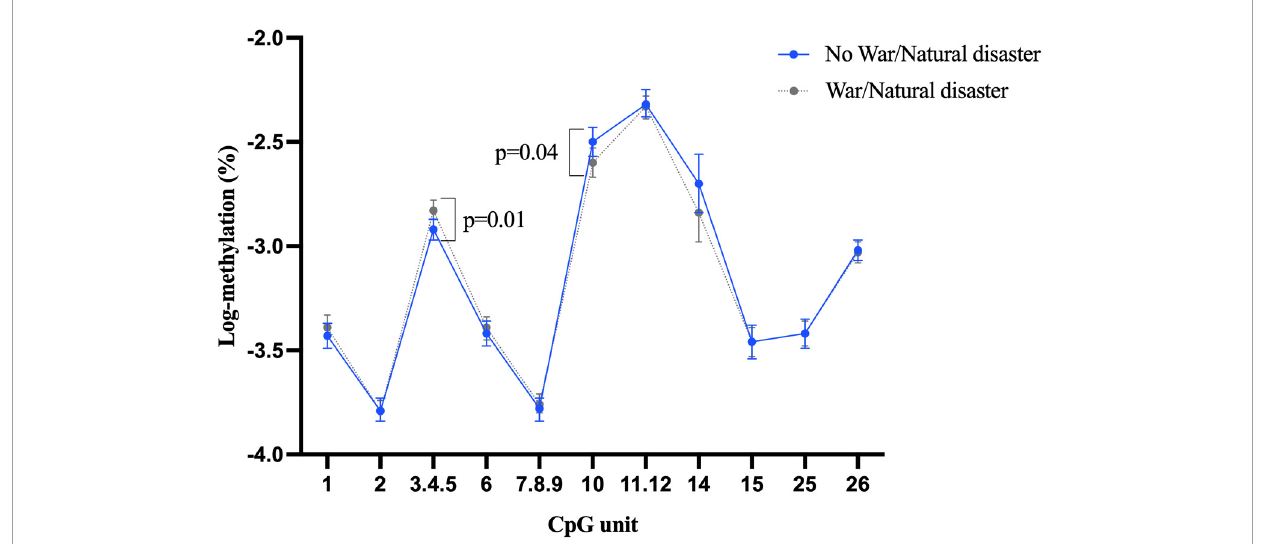
FIGURE1 Childhood experience of war/natural disaster and BDNF methylation at exon I in blood tissue.